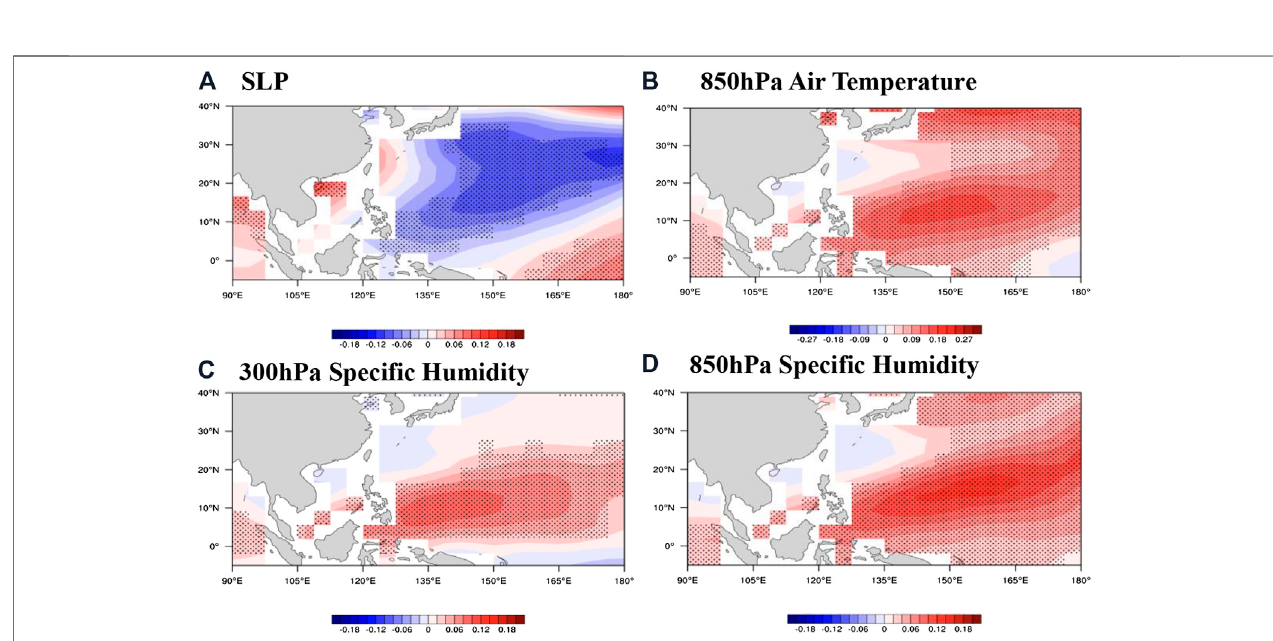
FIGURE6| Theregressionmapsof (A) sealevelpressure(unit:hPa), (B) 850 hPaairtemperatureanomalies(unit:K), (C) 300 hPaspeci fi chumidityanomalies(unit: g · kg -1 ), and (D) 850 hPa speci fi c humidity anomalies (unit: g · kg − 1 ) onto the normalized AMO index for 1950 – 2010 in the ATL_VARMIX experiment. Dotted shading represents the regression coef fi cients signi fi cant at the 95% con fi dence level. The long-term linear trends were removed.